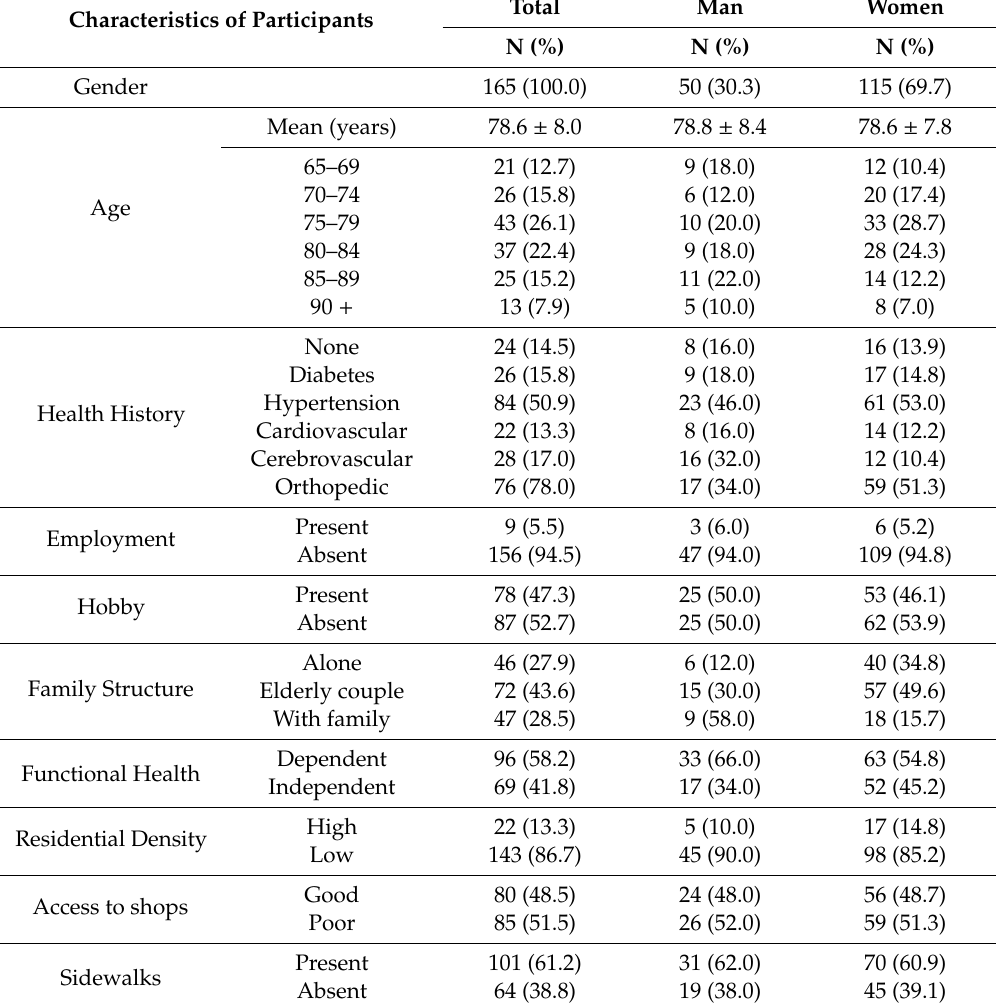
Table 1. The characteristics of